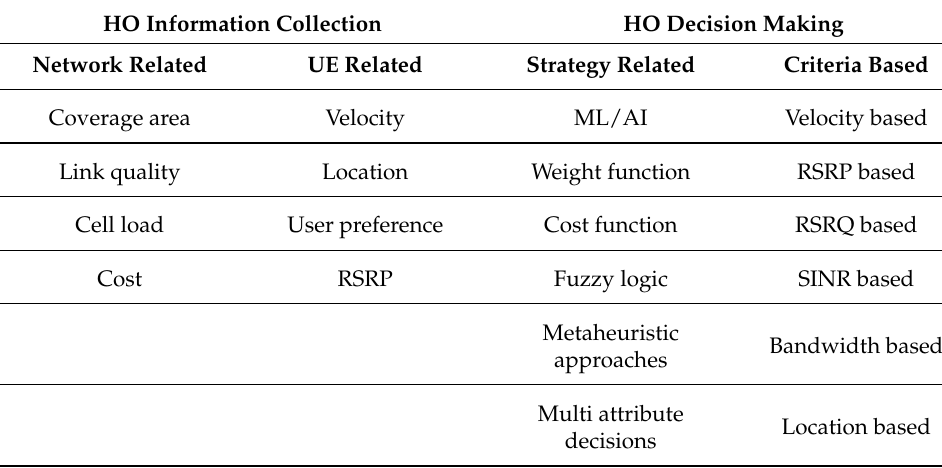
Table 4. HO Information collection and Decision